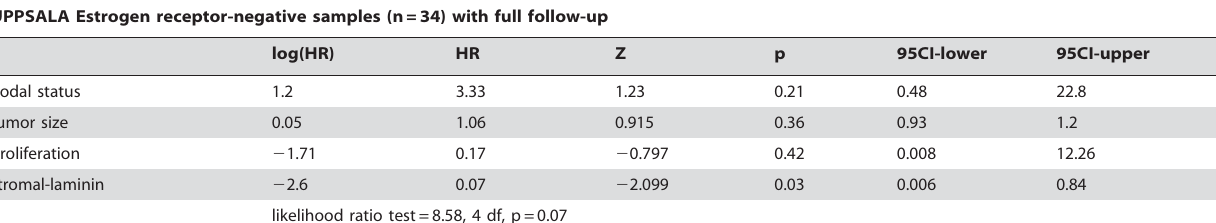
UPPSALA Estrogen receptor-negative samples (n=34) with full follow-up